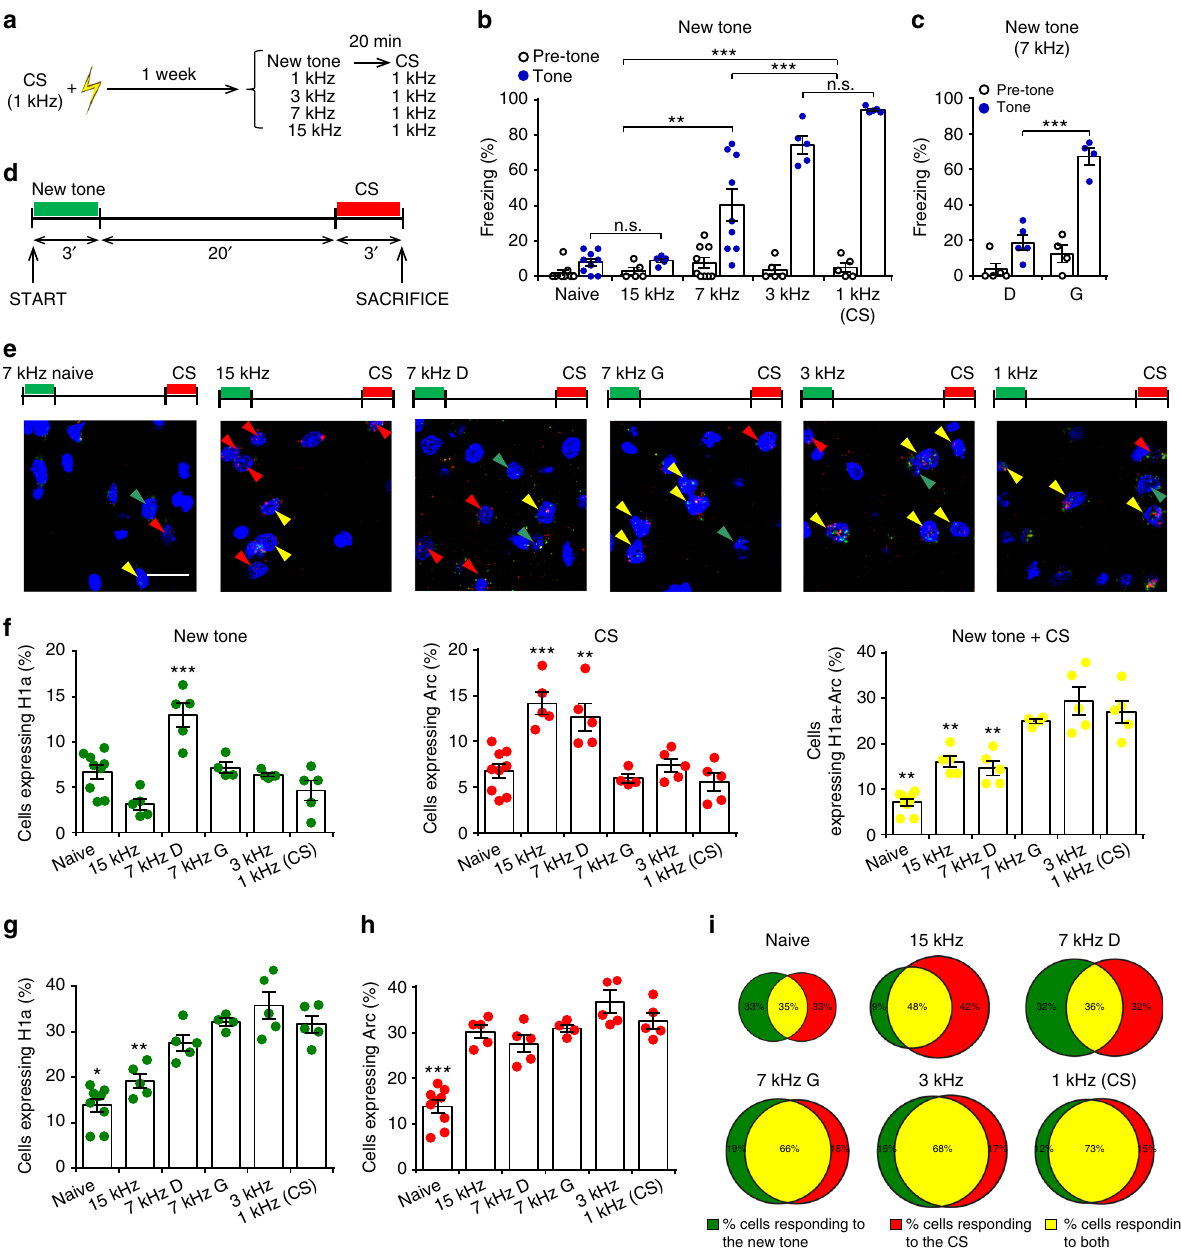
Fig. 1 LA activity following the presentation of novel and threatening cues. a Experimental design of behavioral and catFISH experiments, see Methods. Naive n = 9, 15 kHz, n = 5; 7 kHz, n = 9; 3 kHz, n = 5; and 1 kHz, n = 5. CS conditioned stimulus. b The percentage of freezing following the new tone presentation progressively increased in similarity to the CS ( F (4, 28) = 36.32, P < 0.001). The freezing of naive and 15 kHz animals was similar ( P > 0.05) and, in the meantime, it was lower than freezing of other groups ( P < 0.01). Freezing of 7 kHz animals was different also from 3 kHz and 1 kHz (CS) group ( P < 0.001). c Freezing in “ discriminator ” animals (D, n = 5) was lower than that observed in “ generalizer ” (G, n = 4) animals during the 7 kHz tone delivery ( P < 0.001). d Time course of catFISH experiments. e Representative images showing neurons expressing single nuclear H1a (green arrows) and Arc (red) mRNA expression and double-labeled cells (yellow) in the naive, 15 kHz, 7 kHz (discriminators and generalizers), 3 kHz, and 1 kHz groups. Scale bar, 20 µ m. f Dot plots showing the percentage of cells activated following new tone presentation (expressing only H1a) , CS presentation (only Arc) , and during both events (expressing both Arc and H1a ). These results revealed an increase in H1a (new tone)- or Arc (CS)-expressing neurons and a decrease in double- labeled cells in the “ discriminator ” group ( F (5, 27) = 13.68 (left), P < 0.001; F (5, 27) = 12.68, P < 0.001 (middle); F (5, 27) = 30.28, P < 0.001 (right)). Raw data were expressed as a number of neurons labeled for Arc , H1a or both mRNA divided for the all counted neuronal nuclei analyzed. For each animal, we then calculated the mean of these raw data. g The total rate of H1a was lower in both the naive and the 15 kHz groups than in the other groups ( F (5, 27) = 24.67, P < 0.001). h The total rate of Arc was lower in the naive rats ( F = 28.39, P < 0.001). i Venn diagrams showing the percentage of H1a- (green), Arc- (5, 27) (red), and double- (yellow) labeled neurons in LA in the different experimental conditions. Diagrams ’ size was scaled on the basis of H1a or Arc total ratios, and percentages were calculated by dividing the number of H1a- , Arc-, and double-labeled neurons for the total number of cells activated in at least one of the two events. * P < 0.05, ** P < 0.01, *** P < 0.001. All data are mean and SEM. One-way ANOVA with Newman – Keuls test ( b , f , i , j